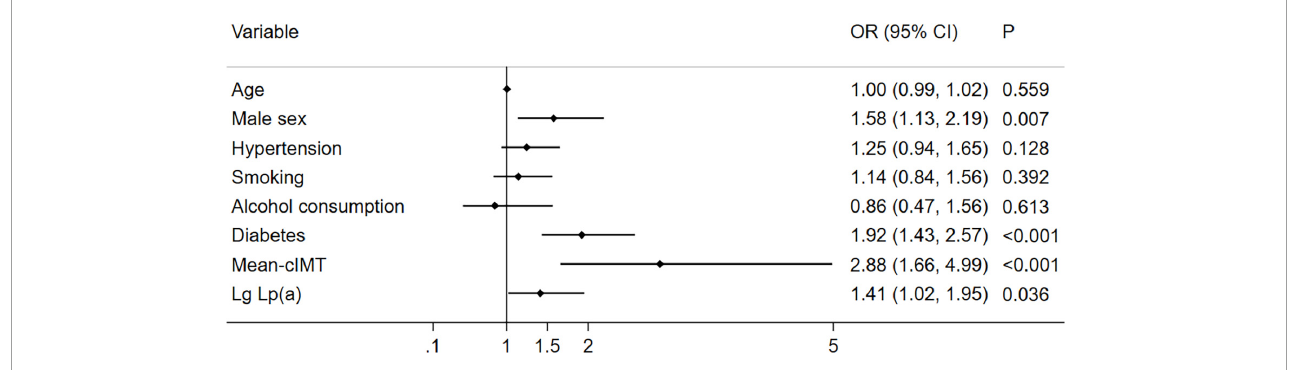
FIGURE3 Relationship between Lp (a) combined with cIMT and multi-vessel CAD ( n = 1004). Illustration: Lp (a) was transferred to Lg Lp (a).